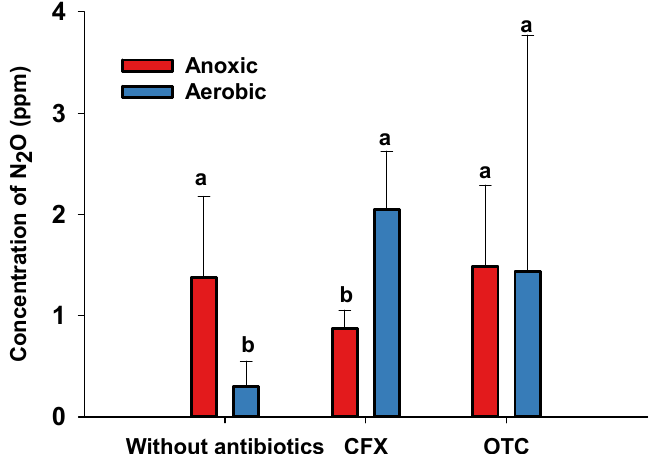
Figure 6. Concentration of nitrous oxide (N 2 O) under aerobic and anoxic conditions for strain RAD-17 with different treatments. Columns containing different letters indicate significant differences among concentrations of the same antibiotic at p = 0.05.